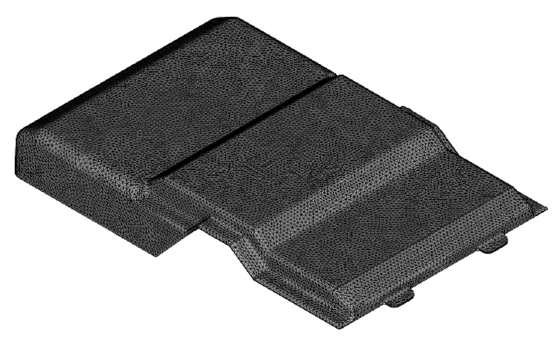
Figure 1. Modeled and meshed part used in the simulation.